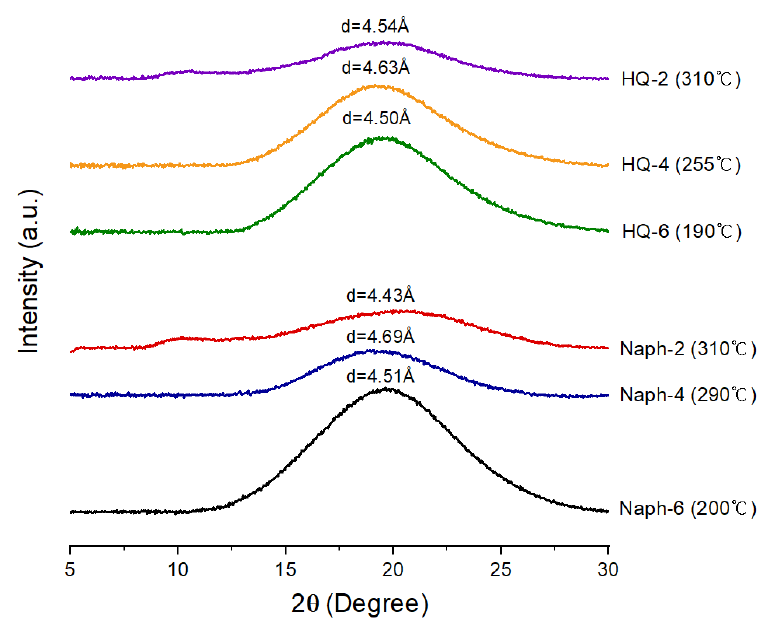
Figure 8. XRD patterns of HQ‐ and Naph‐TLCPs in the LC mesogenic temperature ranges. The temperature in parentheses is the temperature at which the XRD patterns were collected.